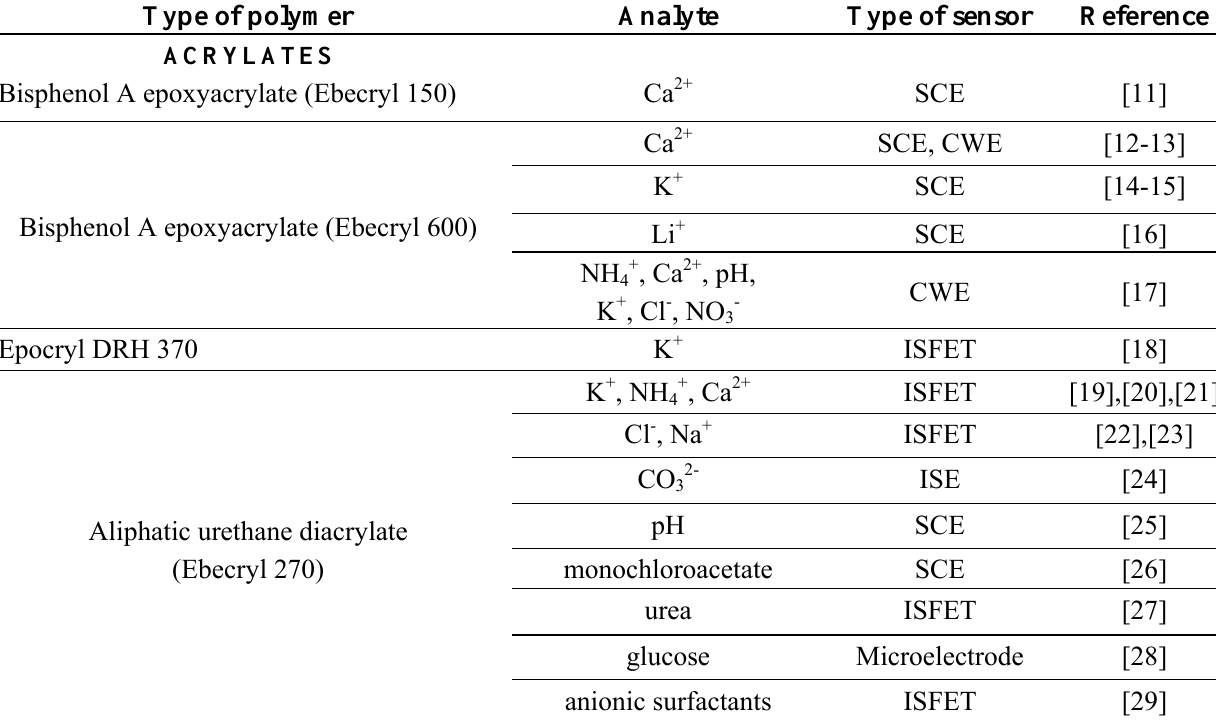
Table 1. Photocurable applied polymers as membrane matrices for chemical